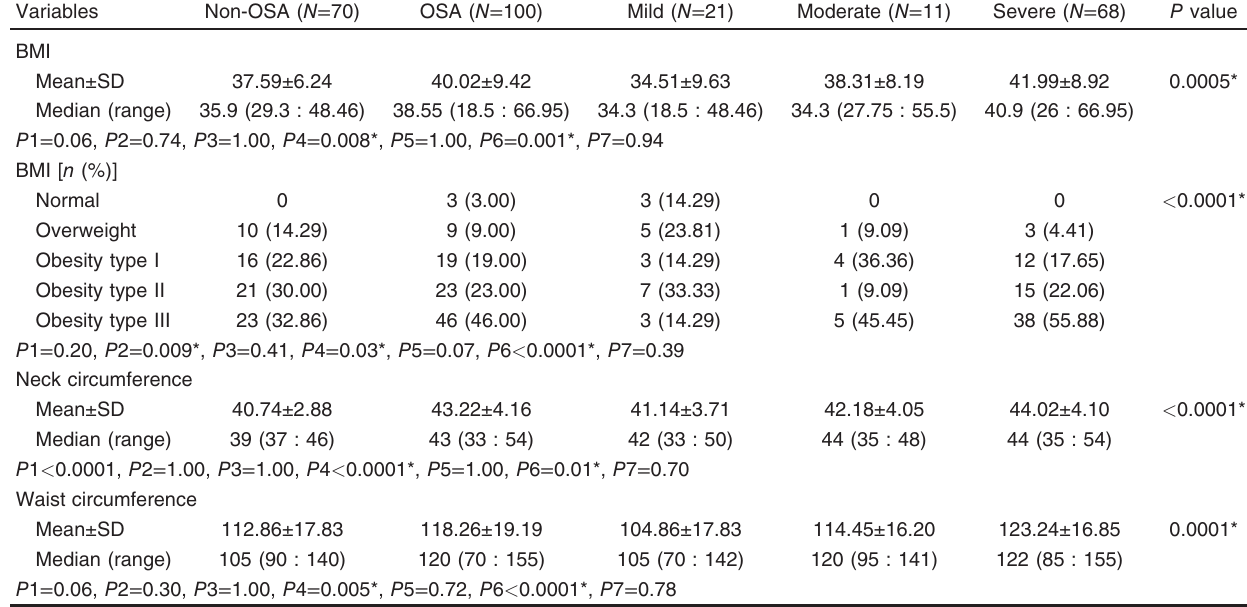
Table 2 Comparison between severity of obstructive sleep apnea and anthropometric measures of studied populations